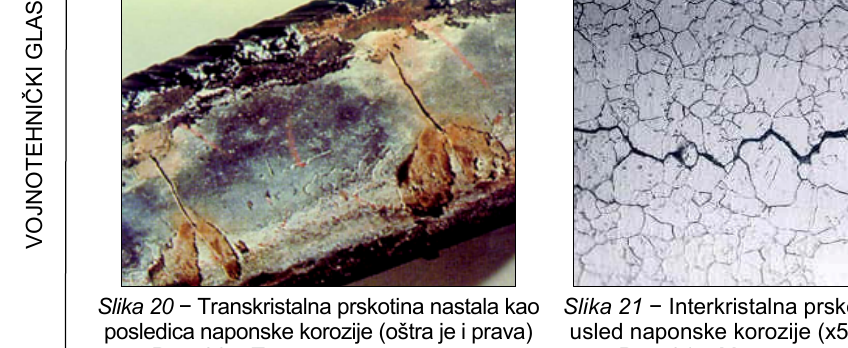
Рис . 21 − Межкристаллитное коррозионное растрескивание под напряжением (x500 Inconel) Figure 21 – Intergranular stress corrosion cracking (x500